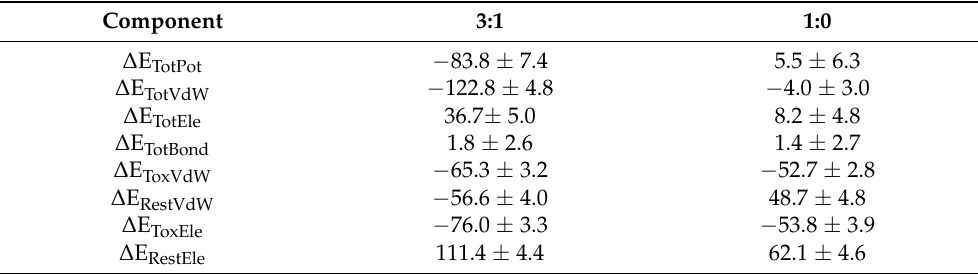
Table 2. Average energy differences in kcal/mol between bound and unbound states for the 3:1 and 1:0 systems